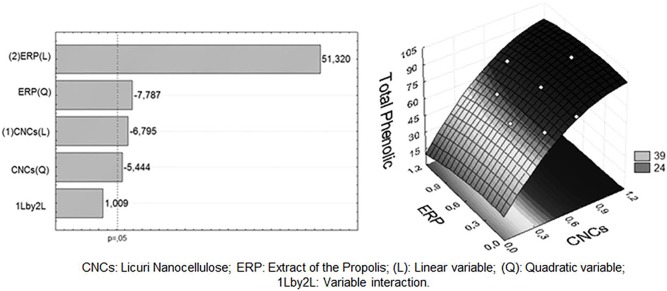
Pareto graph (A) and response surface (B) generated between CNCs, Total Phenolic and ERP.